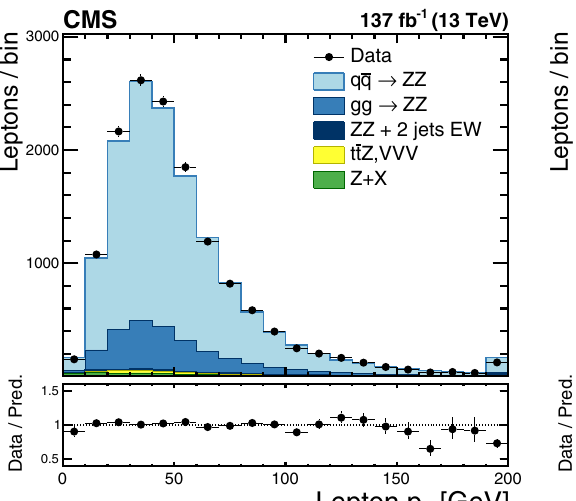
predictions and reducible background estimated from data. The p T dis- tributions includes overflow in the last